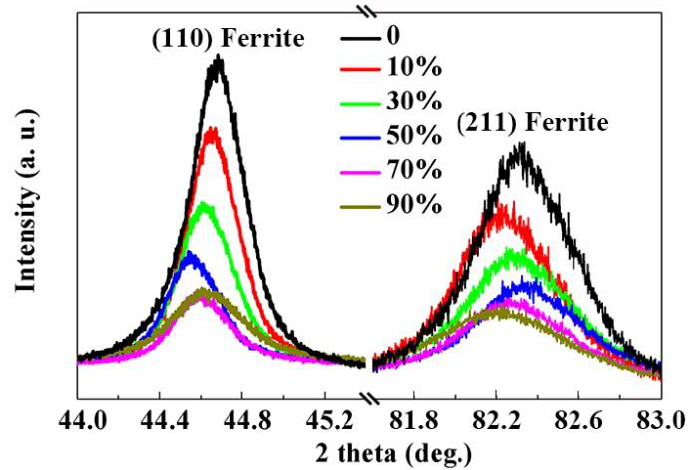
Figure 7. XRD diffractograms of the (110) and (211) ferrite peaks at different rolling reductions.